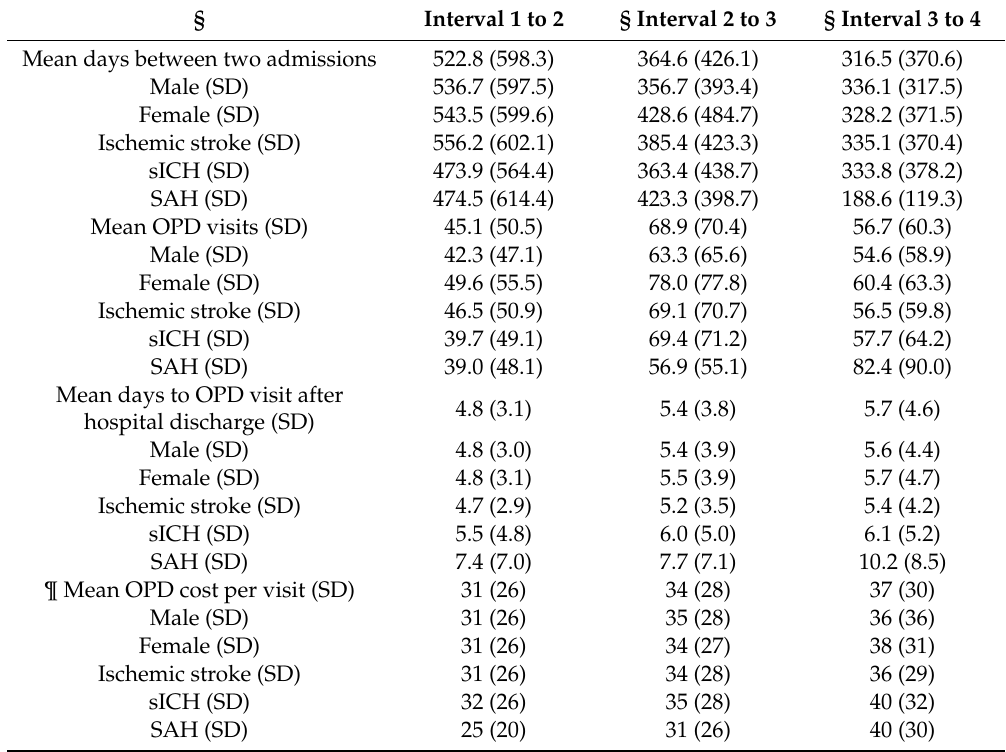
Table 3. Comparison of demographic data between two hospital admissions. § Interval 1 to 2 § Interval 2 to 3 § Interval 3 to